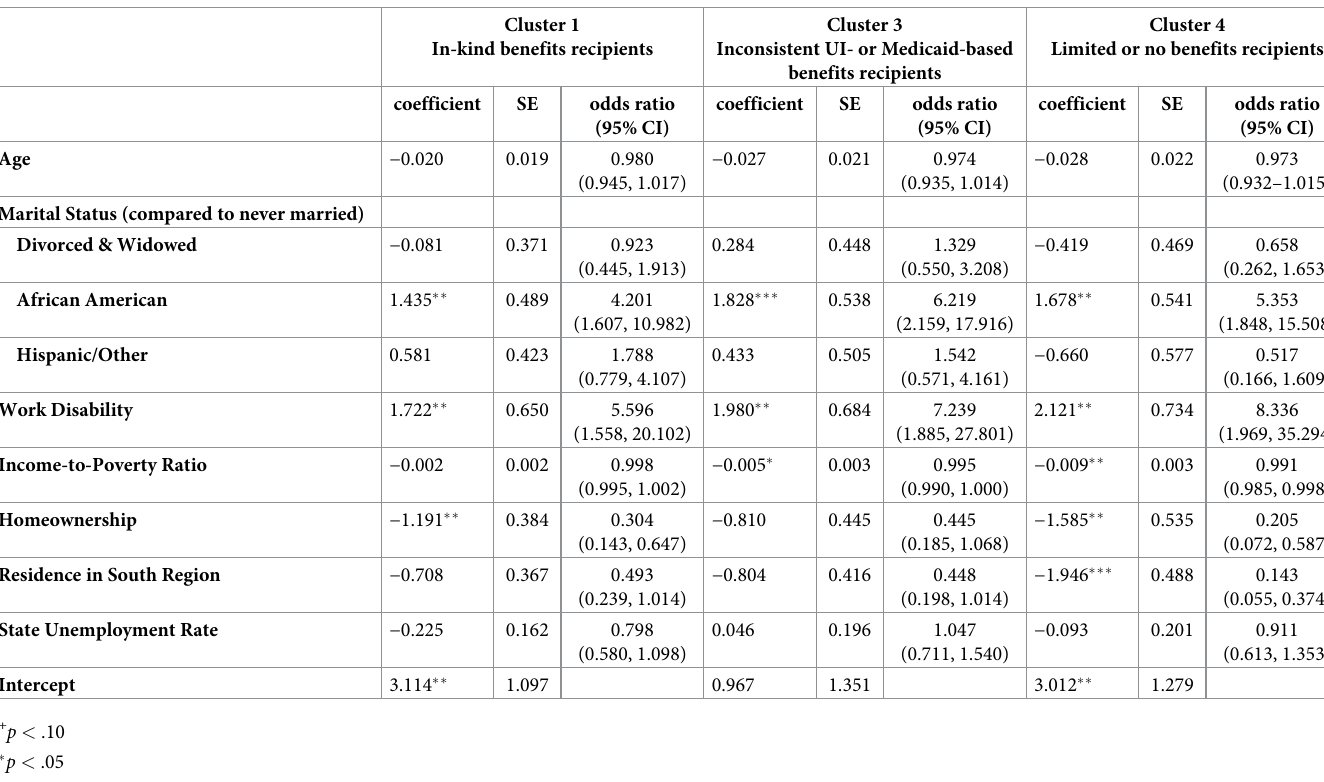
Table 3. Multinomial logistic model of multiple program participation cluster